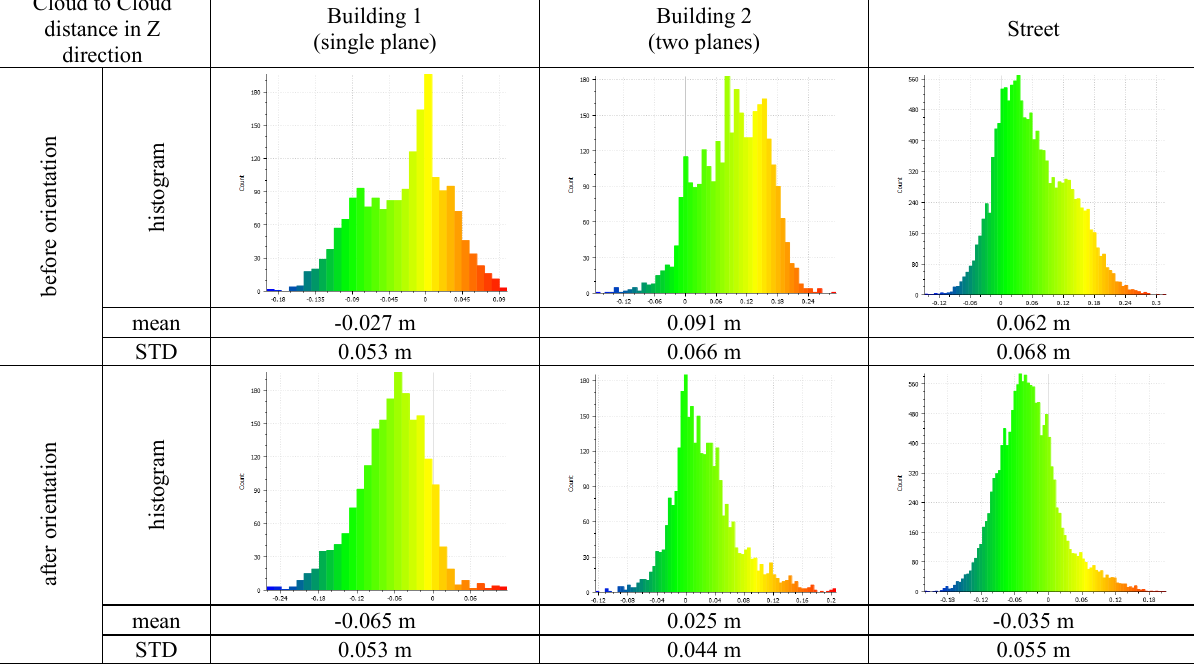
Table 1. Histograms of distances in the Z direction between ULS point clouds and reference TLS point cloud for the Płock test site (with local plane modelling with least